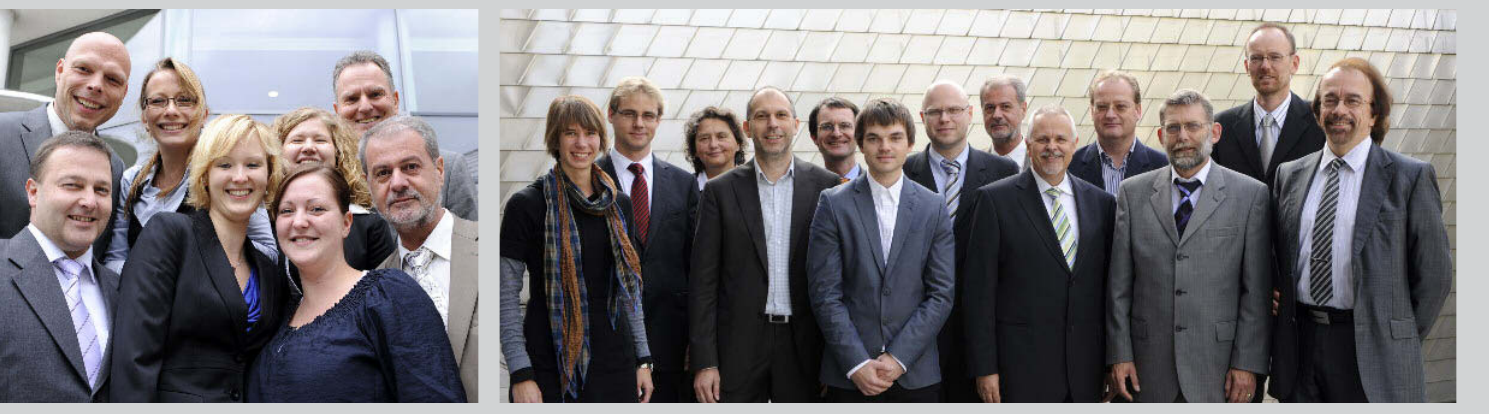
Figure 1 (left): Rüdiger Brummer (right) and his team. Figure 2: The